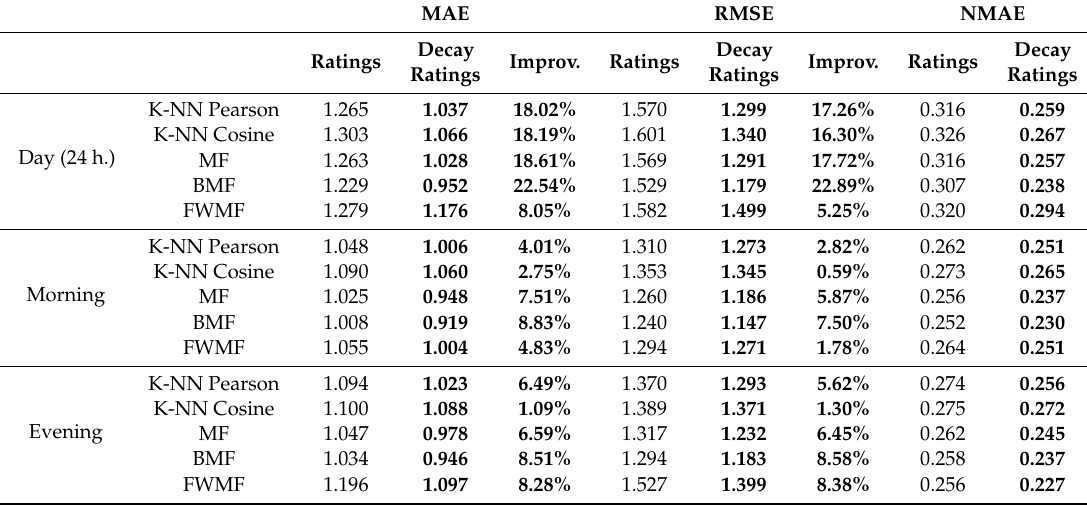
Table 1. The root-mean-square error (RMSE), mean absolute error (MAE) and normalized mean absolute error (NMAE) values obtained for the rating prediction when contextual information is not considered (day) and when contextual pre-filtering is carried out (morning and evening). MAE RMSE NMAE Decay Decay Decay Improv. Ratings Ratings Improv. Ratings Ratings Ratings Ratings